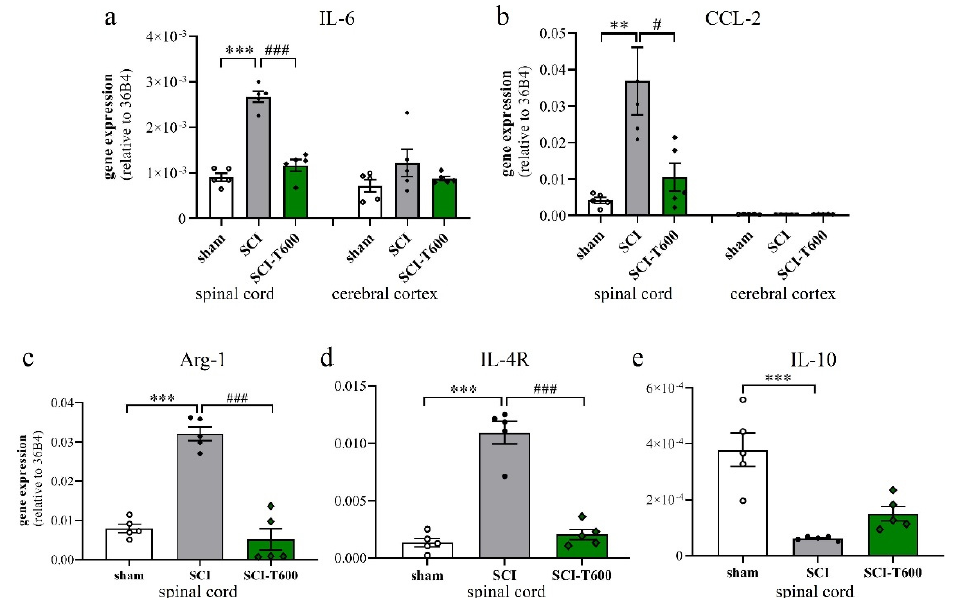
Figure 5. Expression of marker genes of inflammation. At 4 dpo, RNA extracts from spinal cord and cerebral cortex were analyzed with quantitative RT-PCR (treatment conditions abbreviated as in Figure 2). ( a ) Gene expression of IL-6 [ANOVA, spinal cord: F (2, 12) = 71.6, p < 0.0001; cortex: n.s.]; ( b ) CCL-2 [ANOVA, spinal cord: F (2, 12) = 8.9, p < 0.01; cortex: n.s.]; ( c ) arginase-1 [ANOVA, F (2, 12) = 56.0, p < 0.0001], ( d ) IL-4R α [ANOVA, F (2, 12) = 66.0, p < 0.0001], ( e ) IL-10 [ANOVA, F (2, 12) = 18.7, p < 0.001]. Significant differences detected with post hoc Dunnett’s tests ( p < 0.05, p < 0.001, p < 0.001) are indicated with **, *** symbols for SCI vs. laminectomy and #, ### for SCI vs.